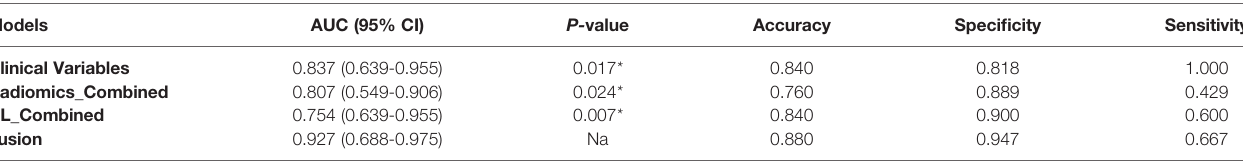
TABLE 4 | Performance measurements generated by DL models and radiomics models trained on four combined sequences (T 1 WI/T 2 WI/FLAIR/DWI) and clinical model trained on clinical variables in the external test dataset.